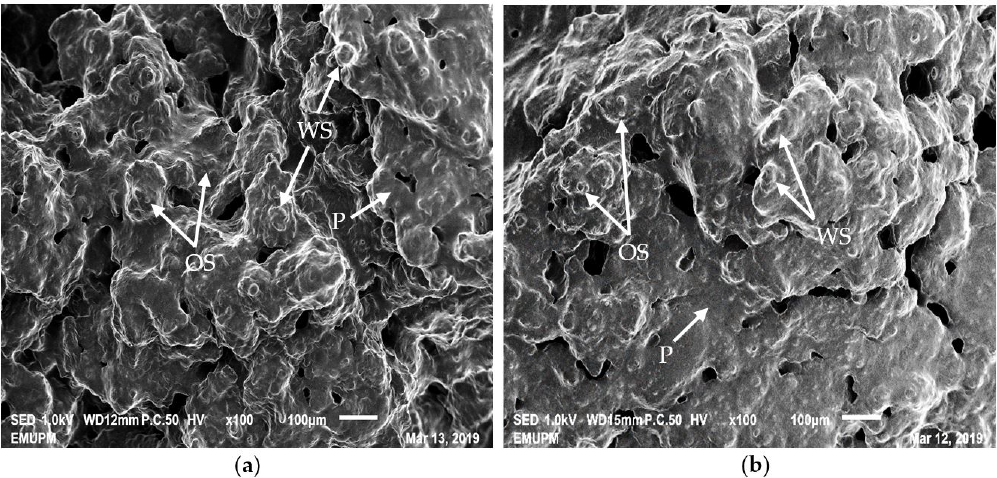
Figure 3. ( a ) Sample S4 (highest stickiness value); ( b ) Sample S8 (lowest stickiness value) at 100 × magnification. OS: oat starch granules; WS: wheat starch granules; P: protein